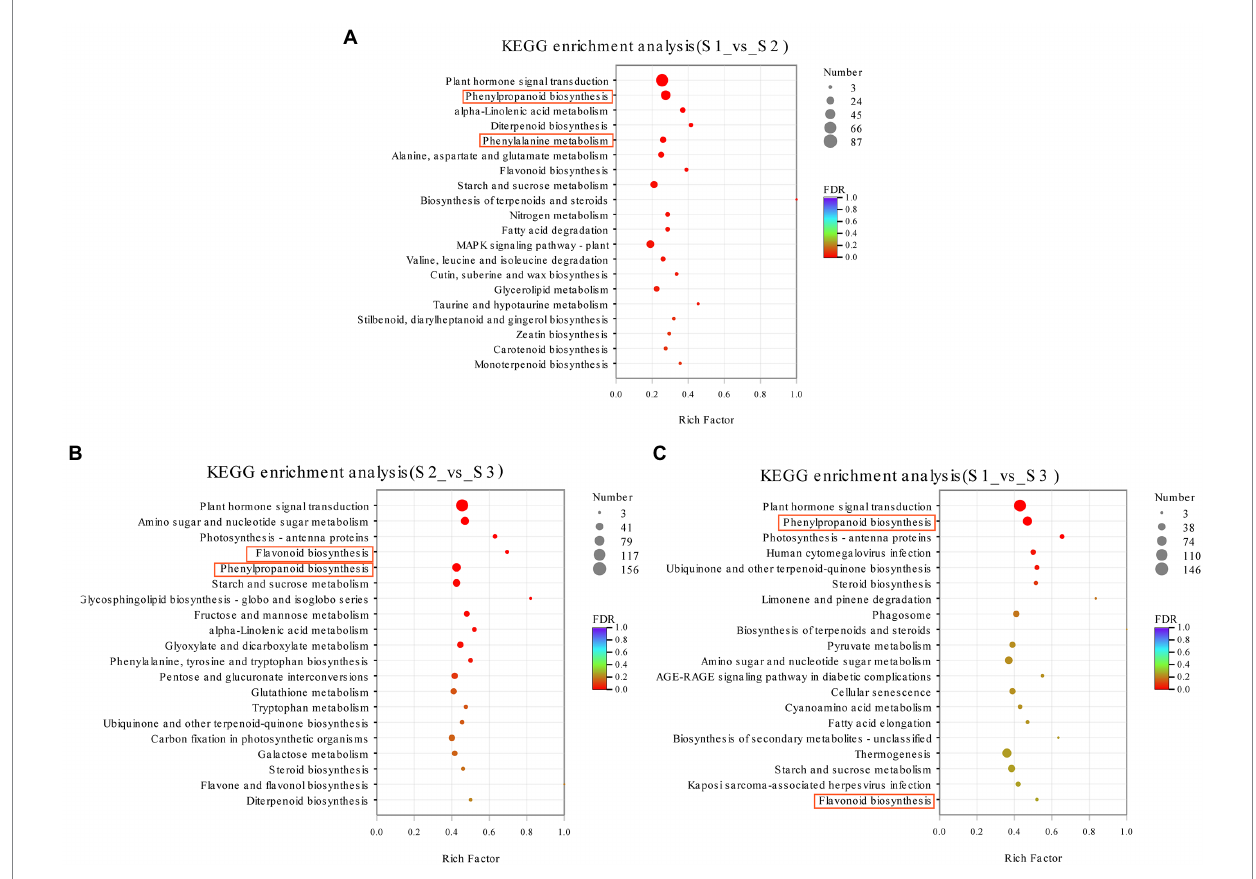
FIGURE 6 Significantly enriched KEGG pathway of all DEGs. (A) Pathway enrichment analysis of DEGs in S1 vs. S2 using the KEGG repository. (B) Pathway enrichment analysis of DEGs in S2 vs. S3 using the KEGG repository. (C) Pathway enrichment analysis of DEGs in S1 vs. S3 using the KEGG repository ( p <